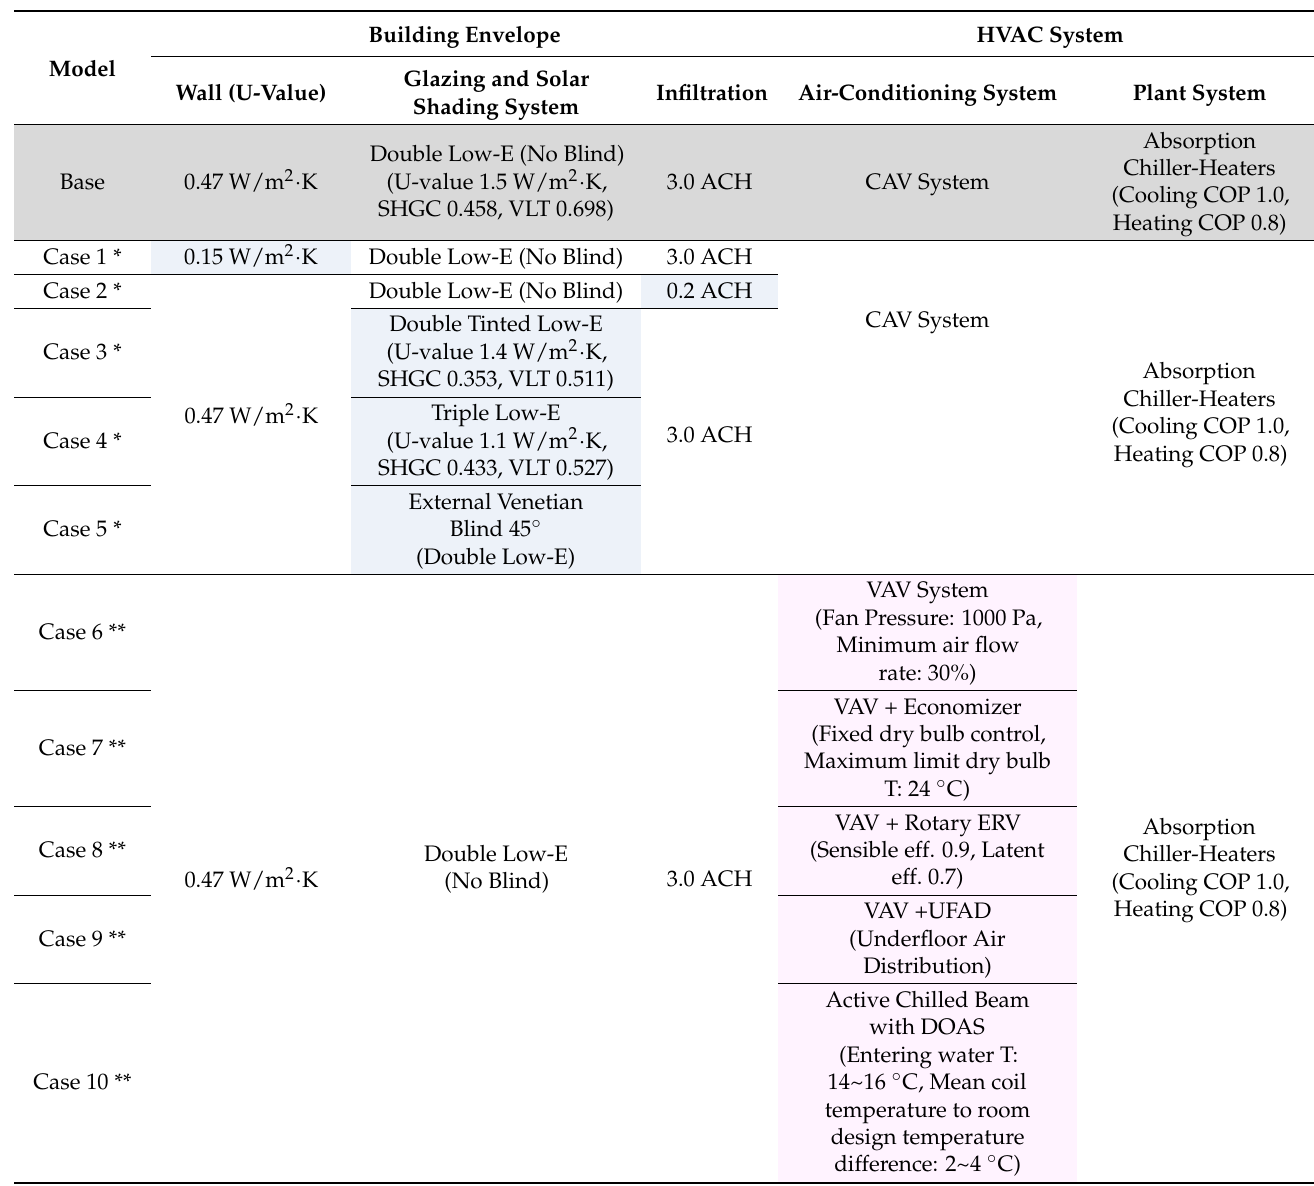
Table 2. Set of simulation variables (passive, active, and renewable energy systems for energy saving) (Grey: base, Blue: passive systems *, Pink: air-conditioning systems **, Yellow: plant systems ***, Purple: renewable systems ****). Building Envelope HVAC System Model Air-Conditioning